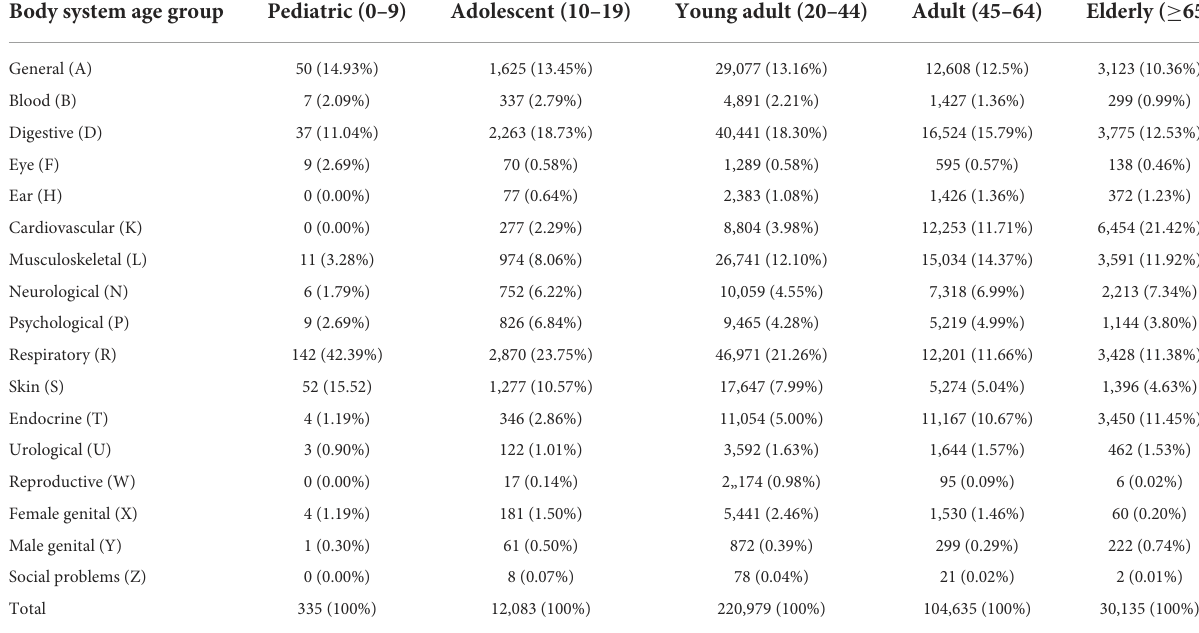
TABLE 2 Distribution of health problems by age